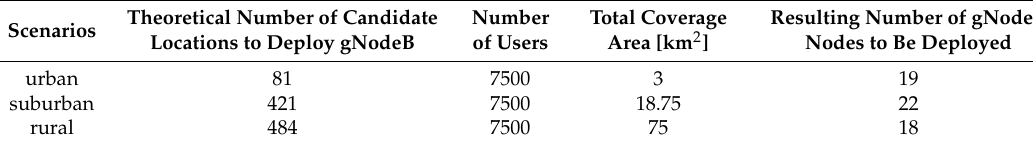
Table 6. Results of different deployment